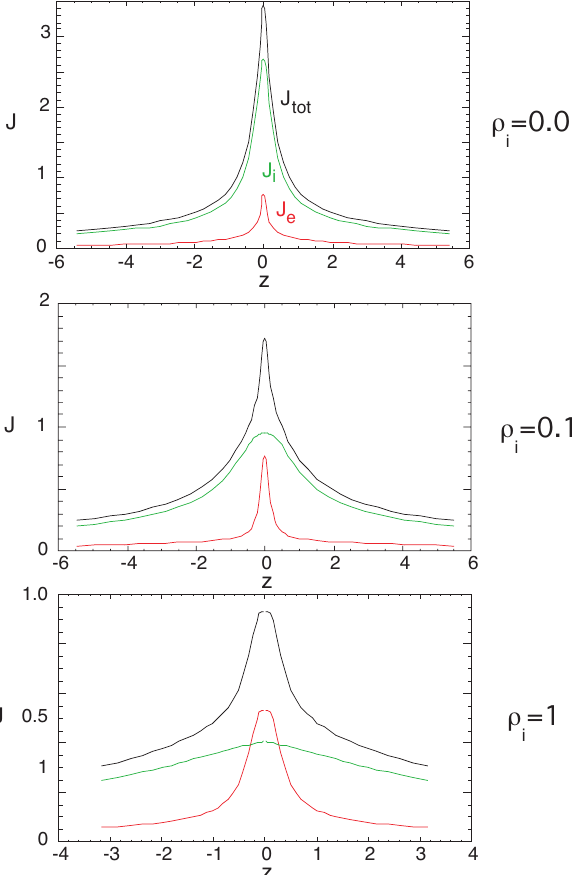
Fig. 1. Ion (green) and electron (red) contributions to the total cur- rent (black) in self-consistent models of a thin current sheet embed- ded in a wider current sheet, for various ion gyroradii scaled by the half-thickness of the wide current sheet; modified after Schindler and Birn (2002).